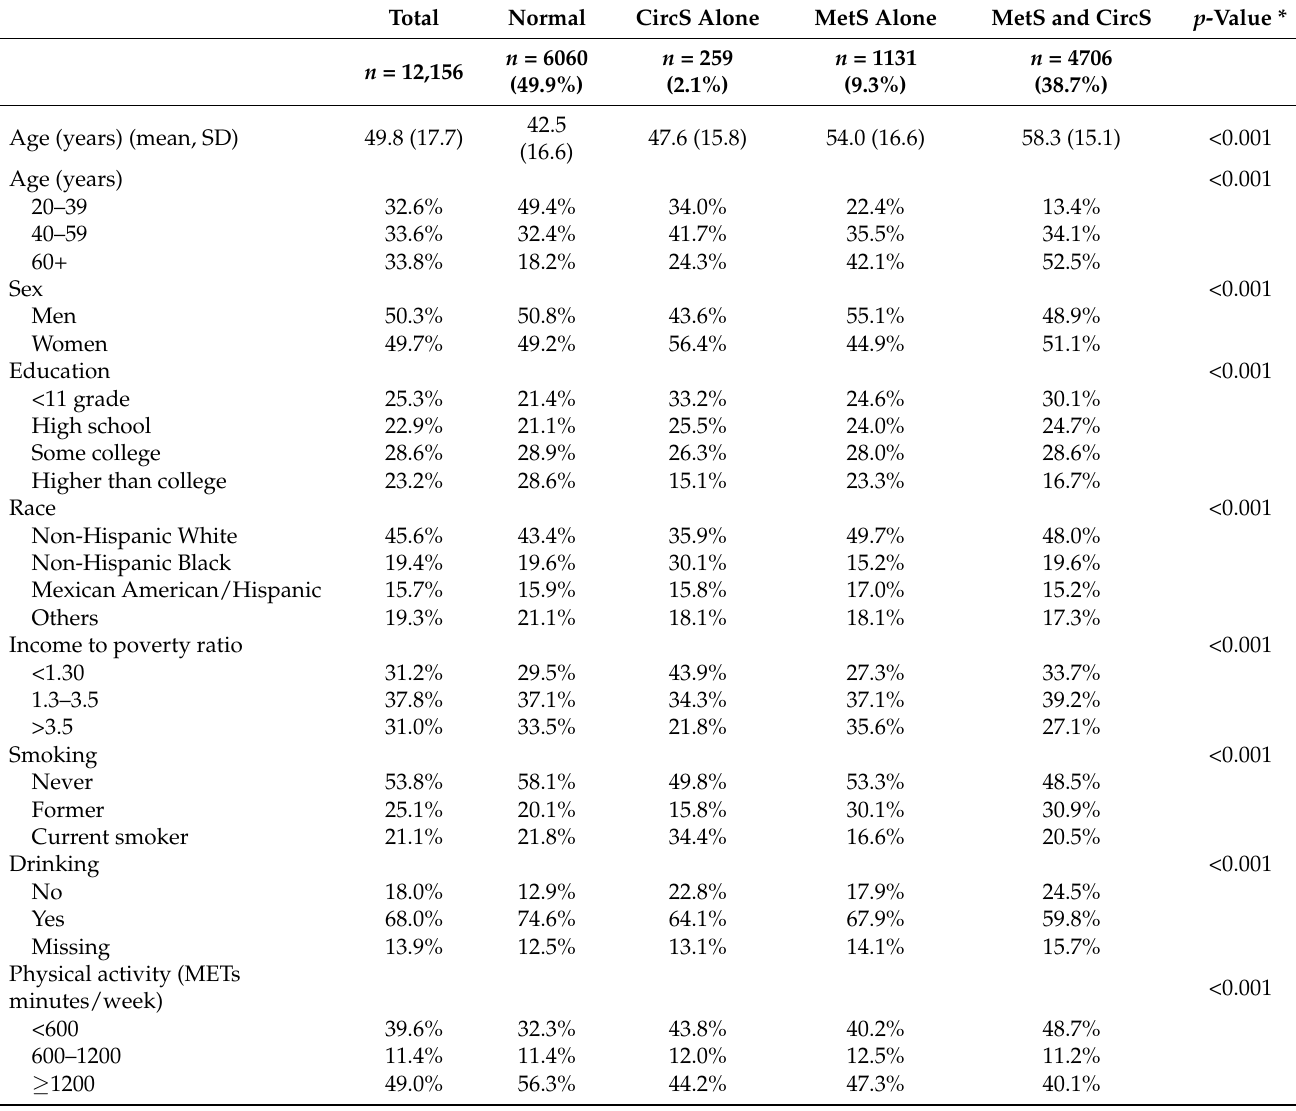
Table 2. Sample characteristics by MetS and CircS status among adults aged above 20 years attending the US National Health and Nutrition Survey (NHANES 2005–2016, n =